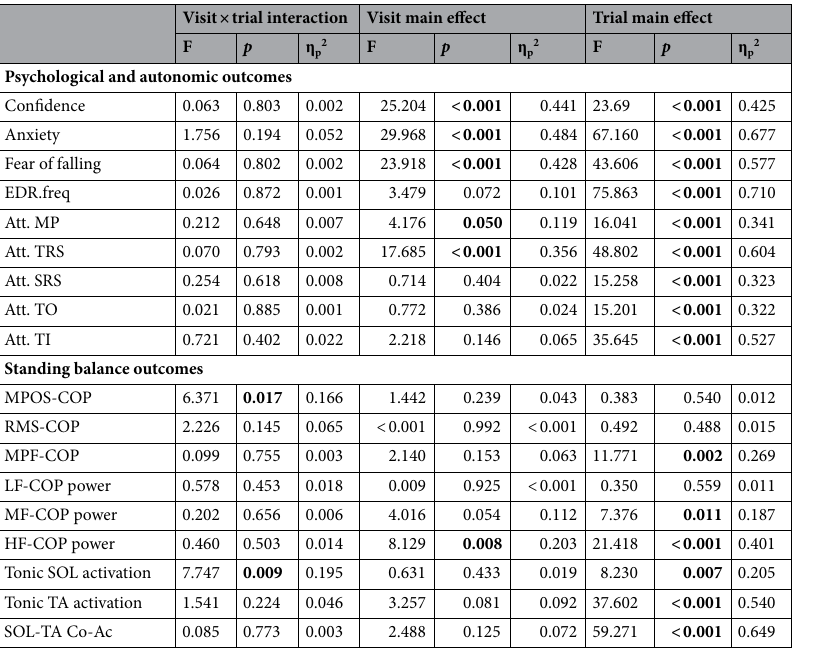
Table 5. Two-way repeated-measures ANOVAs (visit: 1 vs. 2; trial: Δ HIGH 1 vs. Δ HIGH 5 ) examining retention and within-session adaptation of self-report, autonomic, and standing balance outcomes across visits.